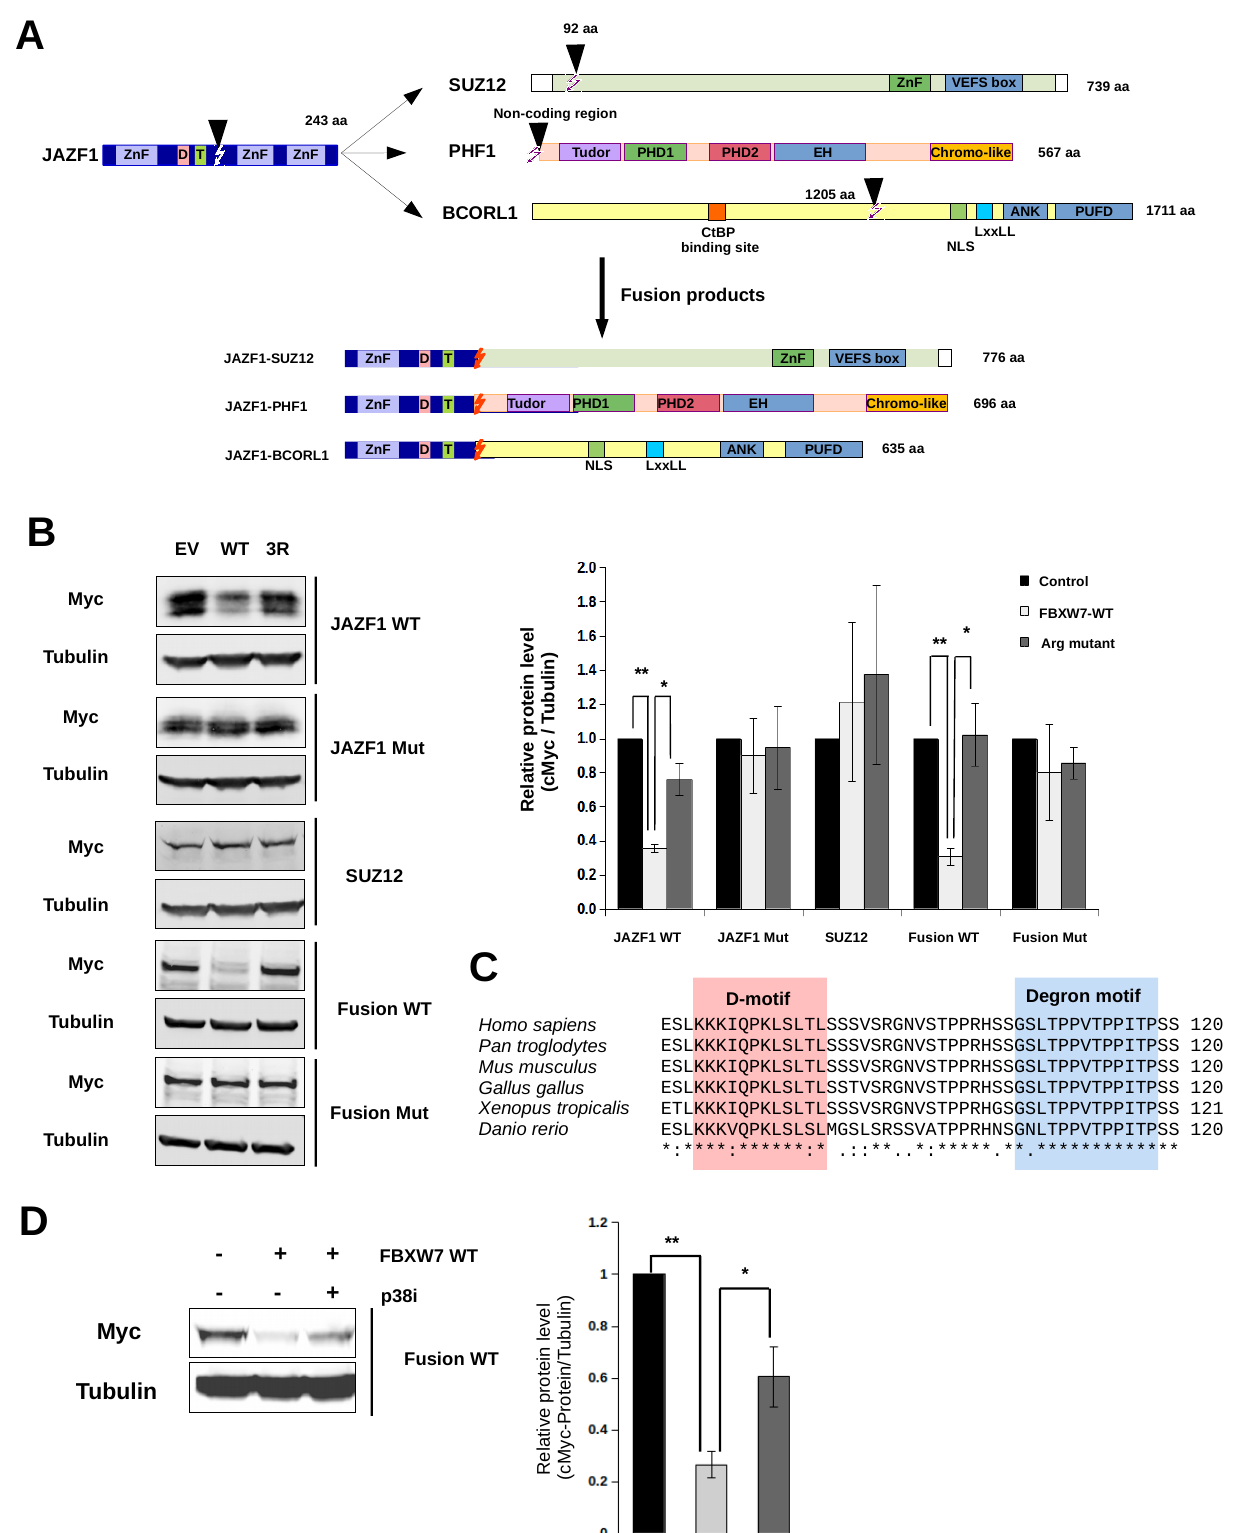
Figure 6. Regulation of JAZF1-SUZ12 fusion protein level by p38-FBXW7 partnership. ( A ) Scheme of JAZF1 fusions known to be associated with endometrial stromal sarcoma. ( B ) Western blot analysis of HEK293T cells transfected with Myc-tagged JAZF1 wild-type (WT), JAZF1 Mut (phosphodegron